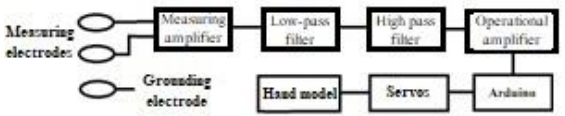
Fig. 5. Block diagram of the designed device [5].